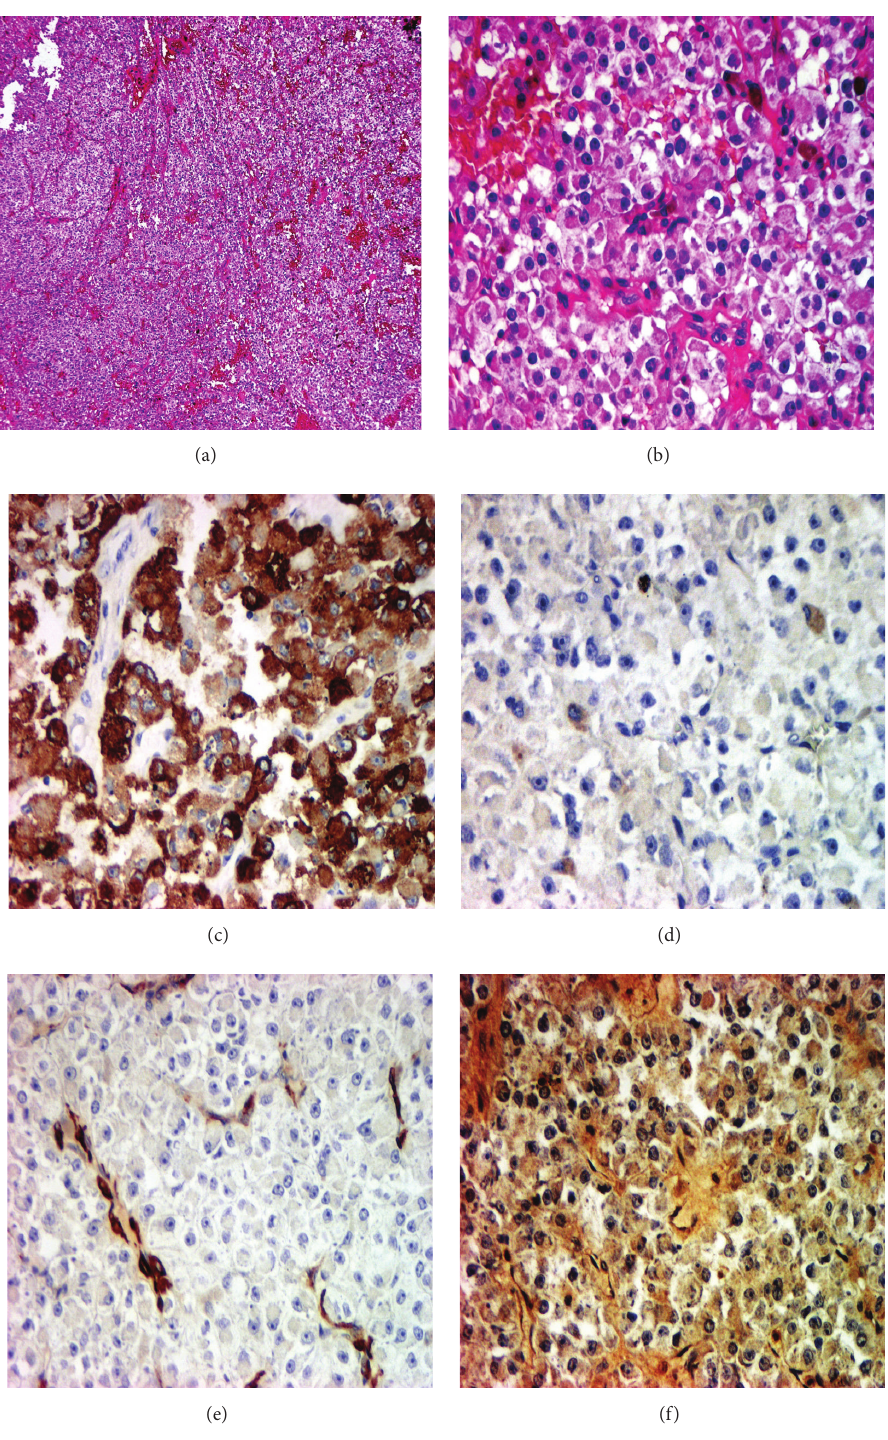
Figure 4: Histology: (a) trabecular architecture and nested growth pattern. HE, 40x. (b) Cell proliferation with an eosinophilic or clear granular cytoplasm; a prominent vasculature composed of delicate thin-walled capillaries was also appreciable. HE, 200x. (c) Immunohistochemical staining showing positivity for HMB45. 200x. (d) Immunohistochemical staining showed negativity for S100 protein. 200x. (e) Immunohistochemical staining for 𝛼 -SMA showed slight staining in tumour cells. 200x. (f) Immunohistochemical staining showed focal positivity for Calponin.